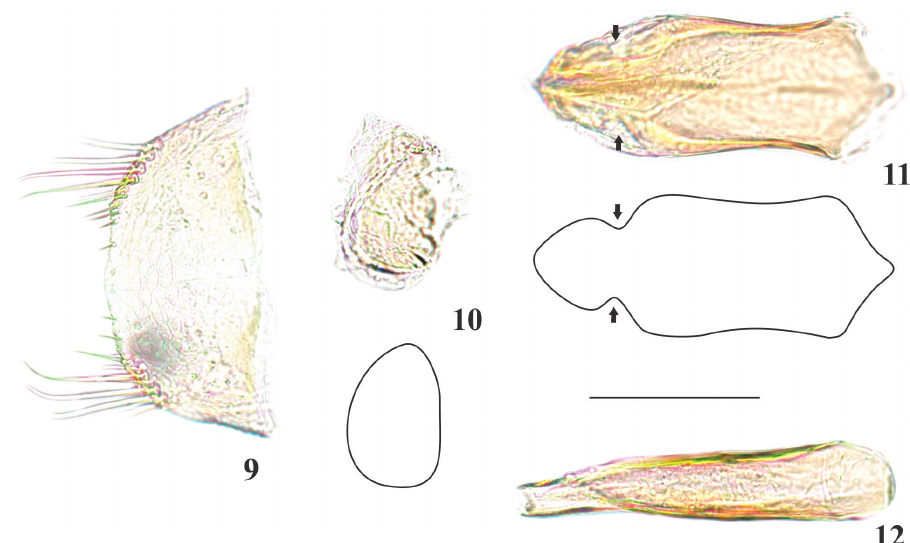
Figures 9–12. Cis mooihoekite sp. n., sclerites of aedeagus of a paratype from the type locality; the ante- rior ends are placed to the right and the posterior ends are placed to the left. 9 Sternite VIII 10 Basal piece (top) and gross outline of basal piece (bottom) 11 Tegmen (top) and gross outline of tegmen excluding membranes (bottom), note emarginations near apex (arrows) 12 Penis. Scale bar: 0.1 mm. Host fungi. Thelephora sp. (Thelephoraceae), one record; and Trametes